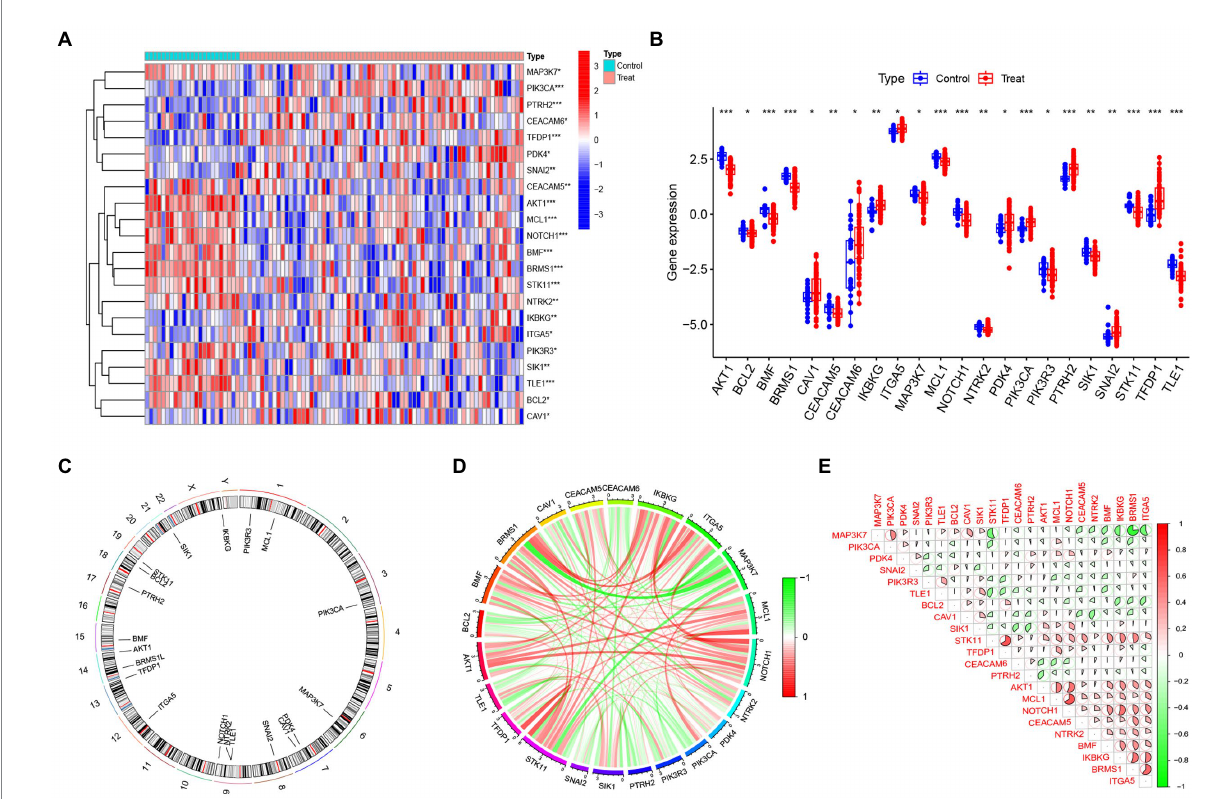
FIGURE 2 Expression profiles of ARGs in IS. (A) Heat map showing the expression of 22 differentially expressed ARGs. (B) Box plot showing the expression differences of 22 ARGs between IS and non-IS samples. (C) Relative positions of the 22 ARGs on the chromosomes. (D) Correlation circle plot showing the correlation of the 22 differentially expressed ARGs. (E) Correlation heat map showing the correlation coefficients of the 22 differentially expressed ARGs. Red and green represent positive and negative correlations, respectively. Correlation coefficients are shown as the area of the pie chart. * p < 0.05, ** p < 0.01, *** p <